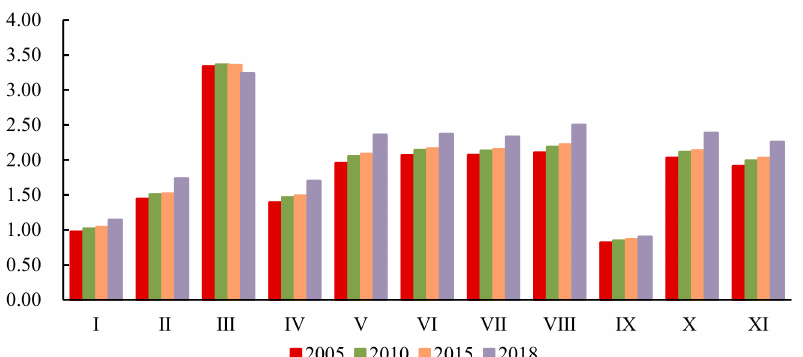
Figure 5. Proportion in ESs value per unit area between the ERAs and NERAs in 2005, 2010, 2015, and 2018. I: Food production; II: Raw material production; III: Water supply; IV: Gas regulation; V: Climate regulation; VI: Decontamination environment; VII: Water regulation; VIII: Aesthetic landscape; IX: Soil maintenance; X: Nutrient cycling; XI: Biodiversity protection.